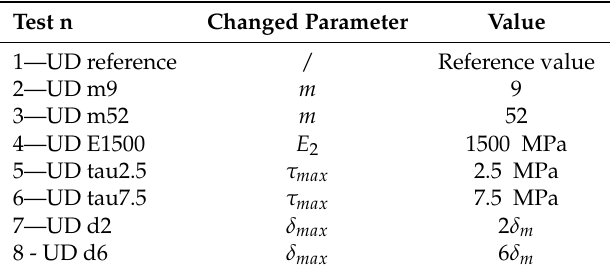
Table 4. Unidirectional tests